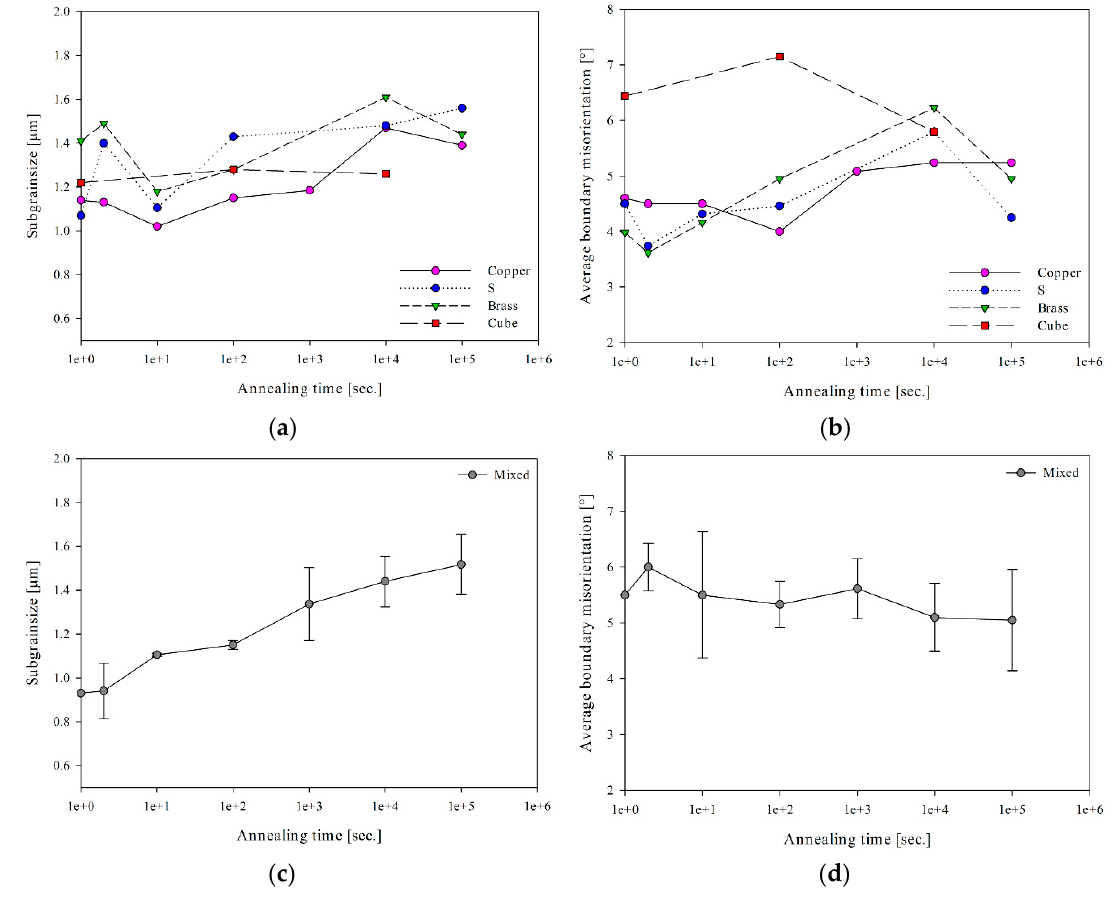
Figure 7. Evolution of subgrain size and average boundary misorientation in special orientations and bulk (mixed orientations) during annealing of CP Al at 250 °C after ( ε = 2.6). ( a ) Orientation-dependent subgrain diameter ( b ) Orientation-dependent average boundary misorientation. ( c ) Orientation-independent subgrain diameter. ( d ) Orientation-independent average boundary misorientation.